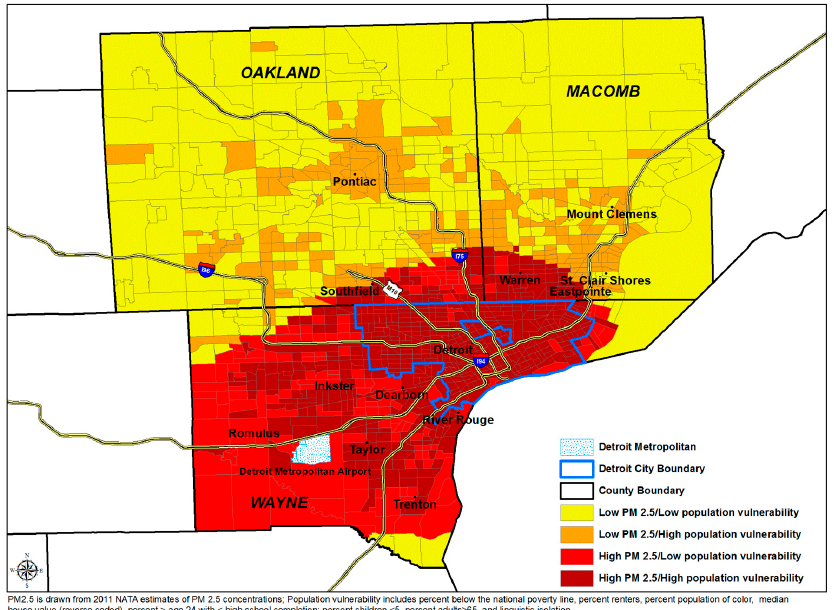
Figure 2. PM 2.5 mapped at the census tract level, Detroit metropolitan area.